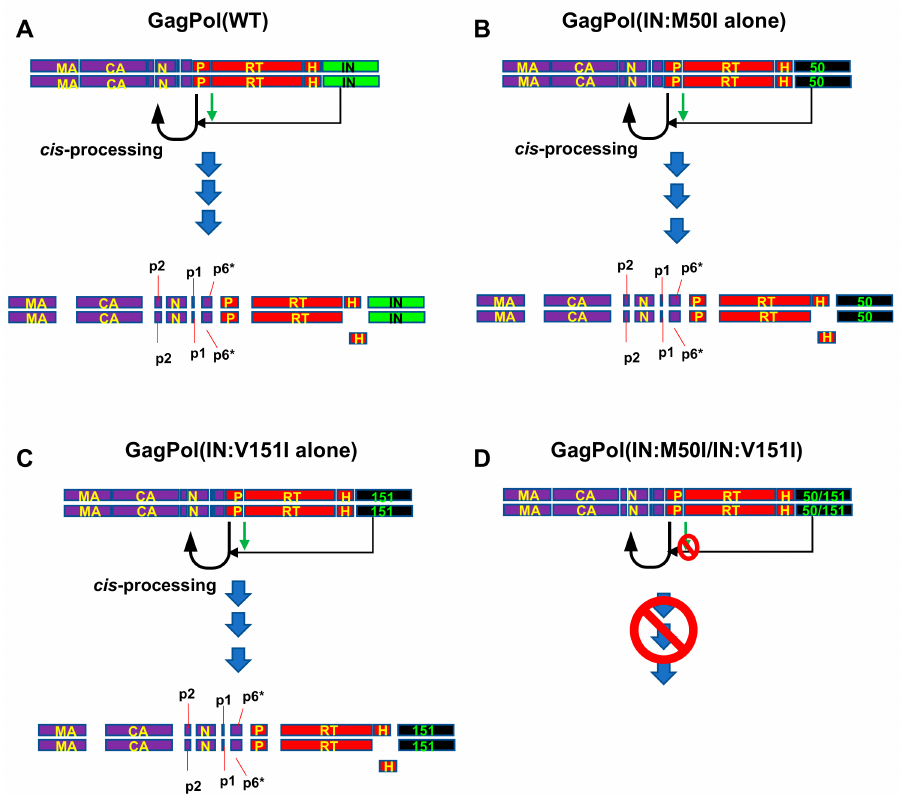
Figure 5. A schematic diagram illustrating IN:M50I/V151I effect. ( A – C ) GagPol polyproteins ho- modimerized, and the embedded PR in GagPol(WT) ( A ), GagPol(IN:M50I) ( B ), or GagPol(IN:V151I) ( C ) cleaves the polyproteins at the cleavage site between P2 and NC as the initial processing [5] and then sequential processing occurs. It is reported that IN positively regulates the initiation of autoprocessing [44–46] and the cleavage site between PR and RT is involved in the regulation (as shown in green arrows) [16]. ( D ) GagPol(IN:M50/IN:V151I) mutations also form homodimers [16]; however, the autoprocessing step is inhibited by an uncharacterized mechanism(s). Green arrows: the cleavage site between PR and RT regulates autoprocessing [16]. The region negatively regulates the autoprocessing in the presence of IN:M50I/V151I mutation via an uncharacterized mechanism.